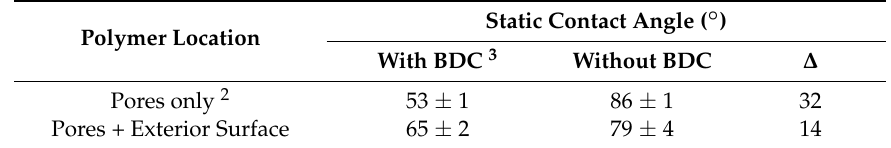
Table 1. Static CA measurements of the prepared 5SBDCSi substrates grafted with PDMAEMA 1 .